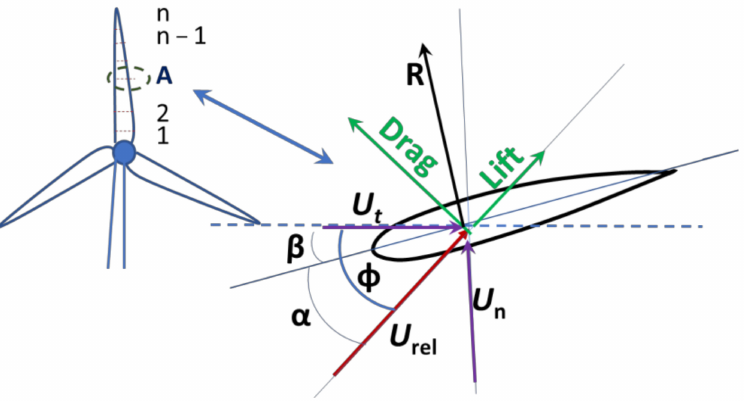
Figure 1. The actuator line force.